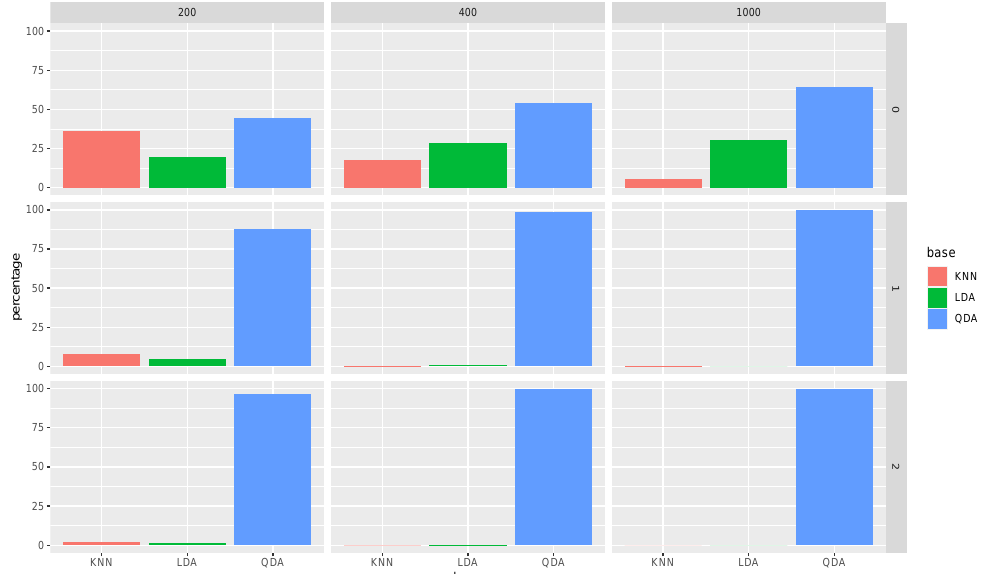
Figure 3. The average selected proportion for each base method for different sample sizes (corre- sponding to each column) and iteration number (corresponding to each row) in Model 2 (QDA).